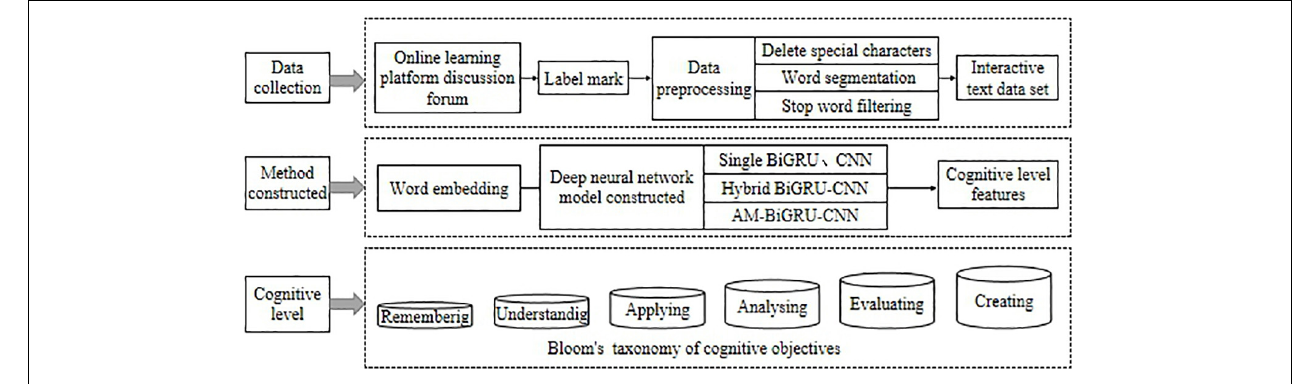
FIGURE 1 | Overview of the cognitive level evaluation.